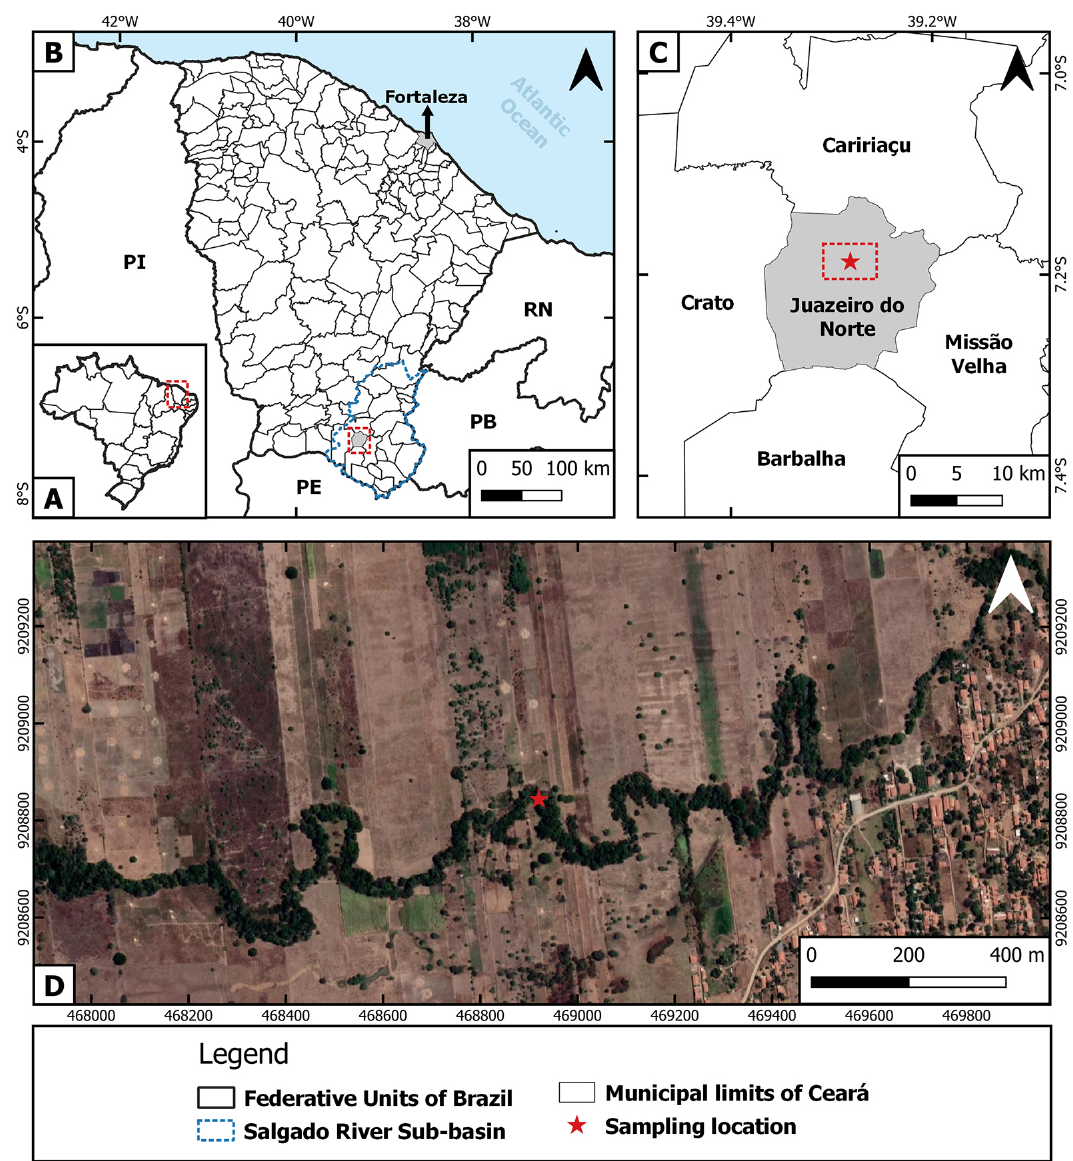
Figure 1. (A) Brazil delimitation; (B) Ceará delimitation; (C) sampling location of Macrobrachium jelskii (Miers, 1877) in municipality of Juazeiro do Norte; River (D ) sampling location of Macrobrachium jelskii (Miers, 1877) in the Batateiras